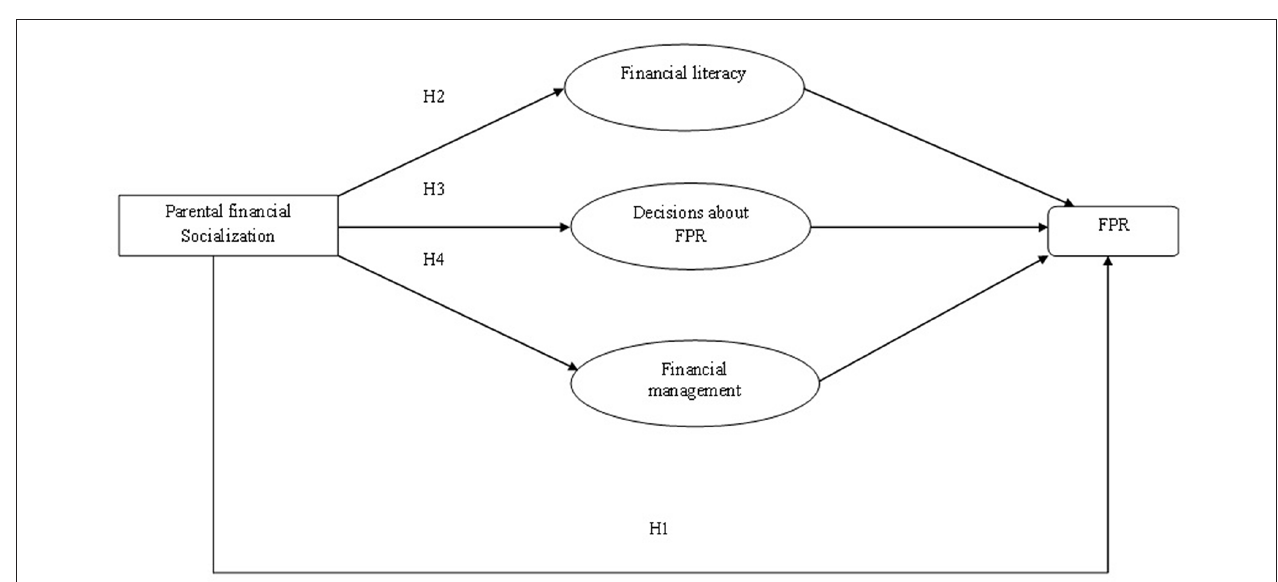
FIGURE 1 | Hypothesized model for the study. Note: FPR, financial planning for retirement.